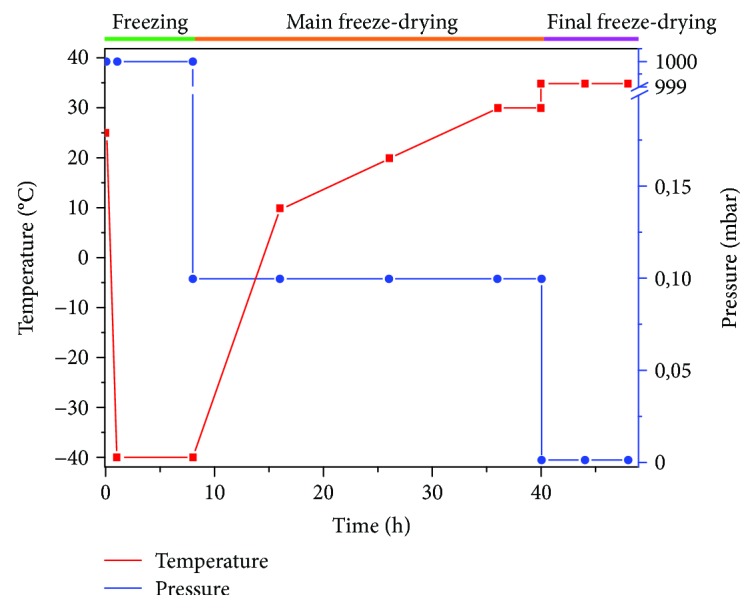
Graph chart of the freeze-drying process.